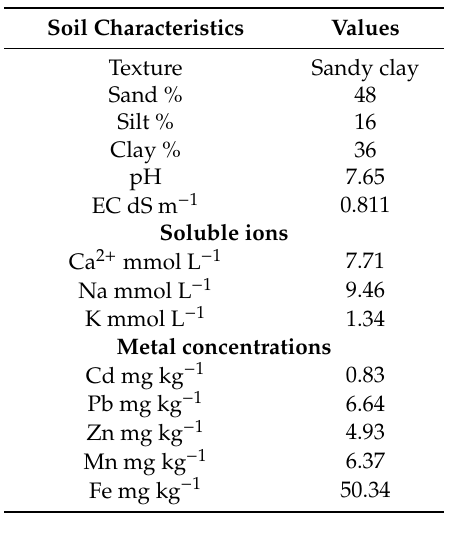
Table 1. The characteristics of the soil used in the experiment of the present